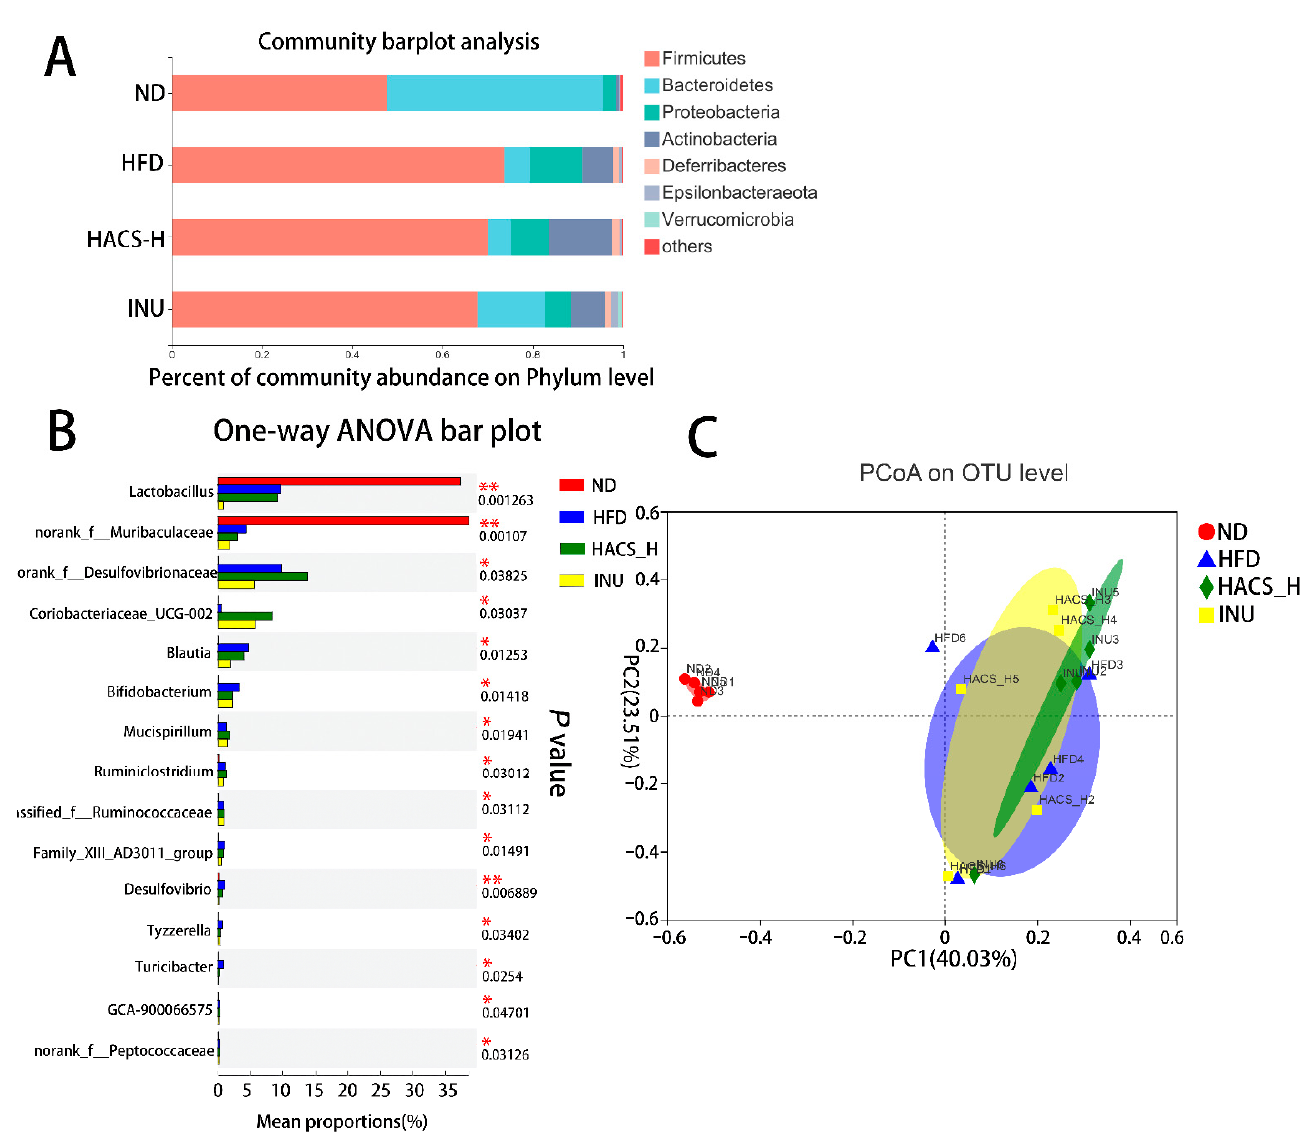
Figure 4. Effects of HACS treatment on gut microbiota composition. ( A ) Community abundance of gut microbiota on phylum level; ( B ) one-way ANOVA analysis of gut microbiota composition on genus level, and ( C ) PCoA analysis of the bacterial community on OTU level. ND, normal diet; HFD, high fat diet; HACS-L, high fat diet + 0.25 g/kg HACS; HACS-H, high fat diet + 0.5 g/kg HACS; INU, high fat diet + 0.5 g/kg inulin ( n = 5 per group).